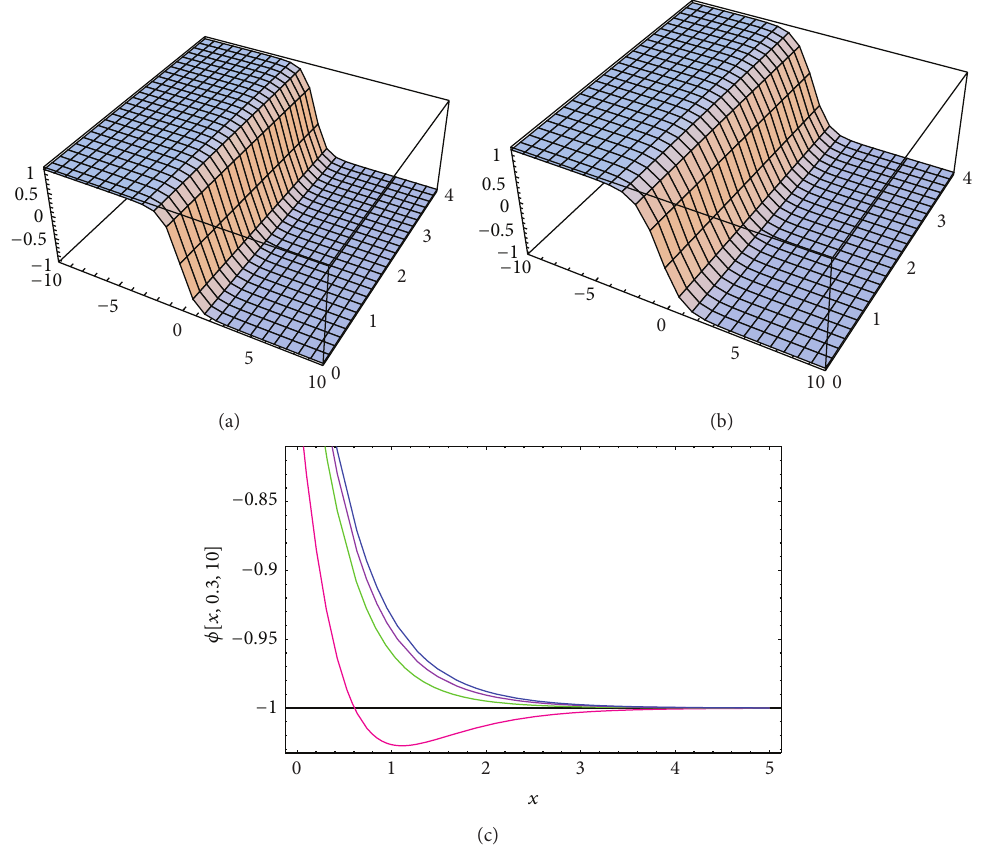
Figure 3: (a) and (b) The surface shows the solution 𝜙(𝑥,𝑦, 𝑡) for (8): (a) approximate solution for 𝛼 = 1.98, ℎ = −1.1 ; (b) exact solution. (c) Four profiles of approximate solutions 𝜙(𝑥,𝑦,𝑡) for some values of 𝛼 : blue line ( 𝛼 = 2 ), mauve line ( 𝛼 = 1.9 ), green line ( 𝛼 = 1.8 ), and red line ( 𝛼 = 1.5 ), when 𝑘 1 = 0.1, 𝑘 2 = 0.03, 𝑘 3 = −0.3, 𝜎 = 𝐼 , and 𝜆 = 1